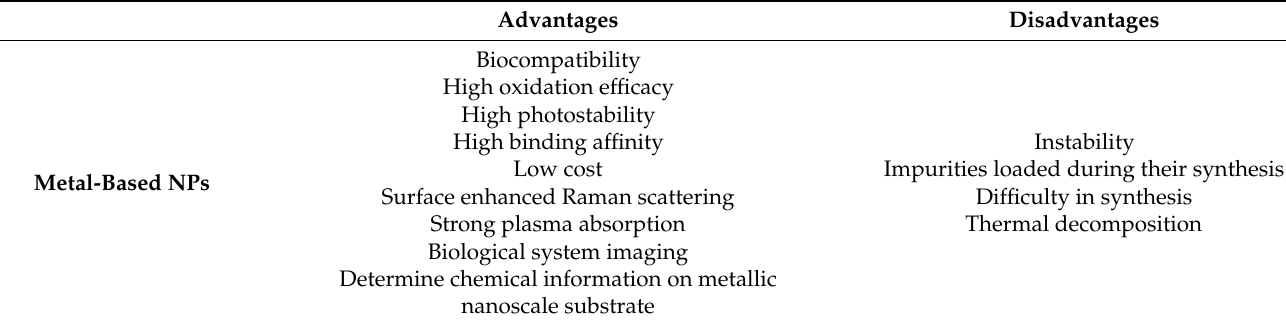
Table 1. Main advantages and disadvantages of metal-based nanoparticles (NPs).